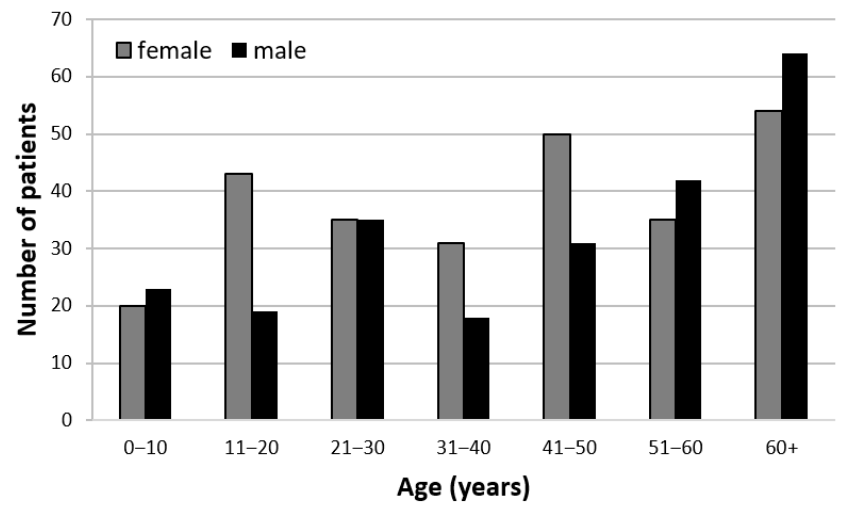
Figure 1. Age and sex distribution of the study sample.